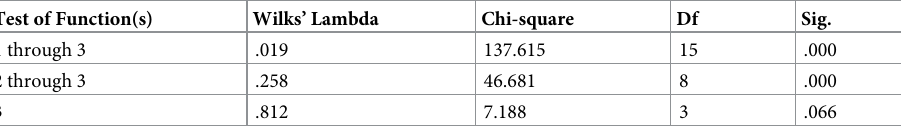
Table 6. Wilks’ Lambda with test of functions during a canonical discrimination analysis.